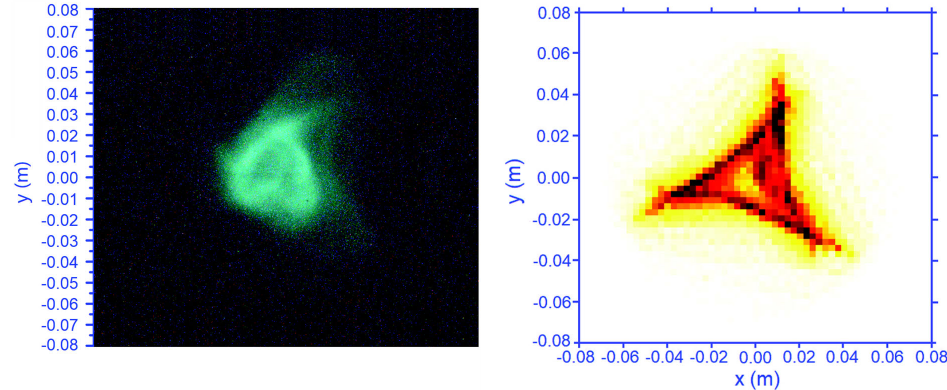
FIG. 5. Beam profile comparison between measurement (left) and simulation